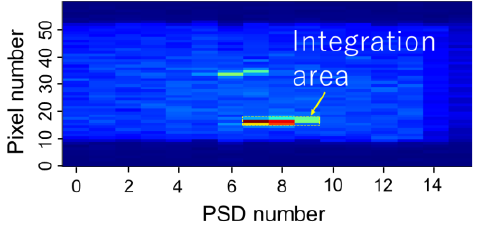
Figure 8. Detector image at 30 T.